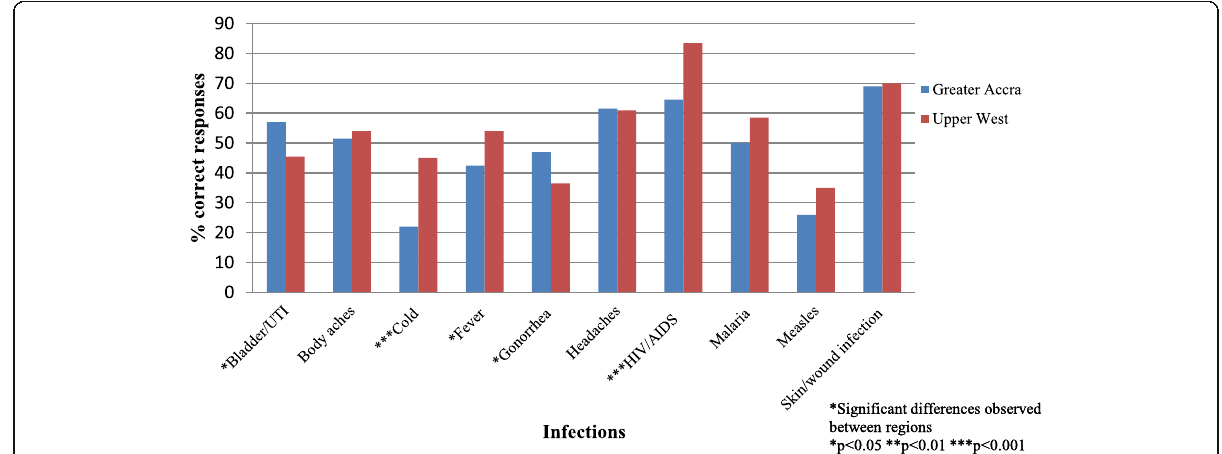
Fig. 1 Percentage of correct responses to the question “ Do you think these infections can be treated with antibiotics?